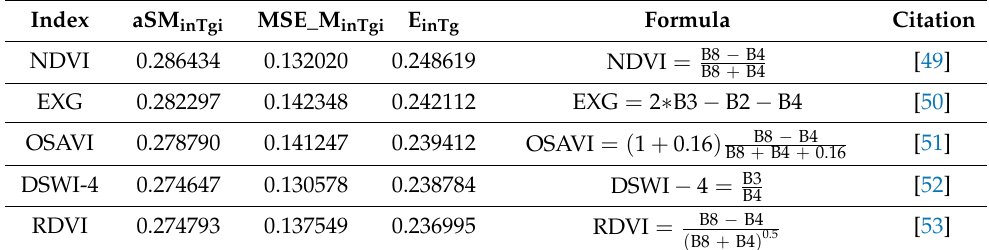
Table 3 . Ranking of the top five indices .